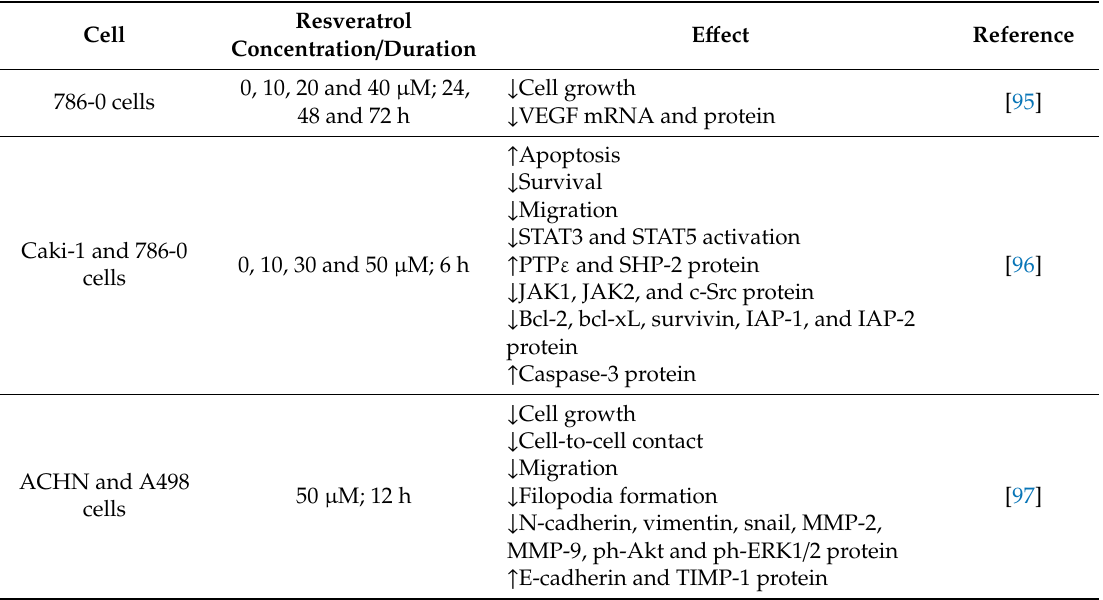
Table 6. E ff ects of resveratrol on renal cancer cells.